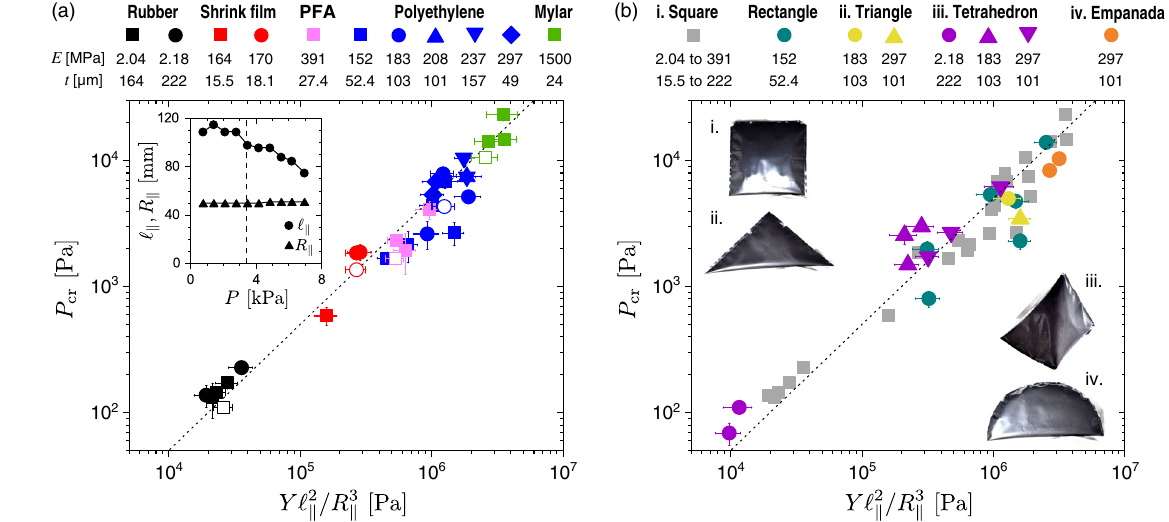
FIG. 6. Pressure threshold for transitioning from sharp crumples to smooth wrinkles in inflated membranes. (a) Experiments using square bags of various thickness ( 15 < t < 222 μ m), width ( 10 < W < 31 cm), and Young ’ s modulus ( 2 . 0 < E < 1500 MPa). Open symbols show the transition for decreasing pressure; the rest of the data are obtained by increasing the pressure. The data are well ¼ 100 (dashed line). Inset: l ¼ 20 cm, described by Eq. (3) with α k and R k versus pressure for a square polyethylene bag ( W cr t ¼ 49 μ m). Both quantities are relatively constant near the threshold pressure (dashed line, P ). (b) Experiments with different bag cr shapes, which are shown in the insets prior to inflation. We use a variety of polyethylene ( E ∼ 200 MPa) and rubber ( E ∼ 2 MPa) sheets to vary the Young ’ s modulus and thickness, as denoted in the legend. Here, 9 . 4 < W < 31 cm. The crumpling threshold is consistent with the result for square bags, as shown by the gray squares and dashed line that are repeated from